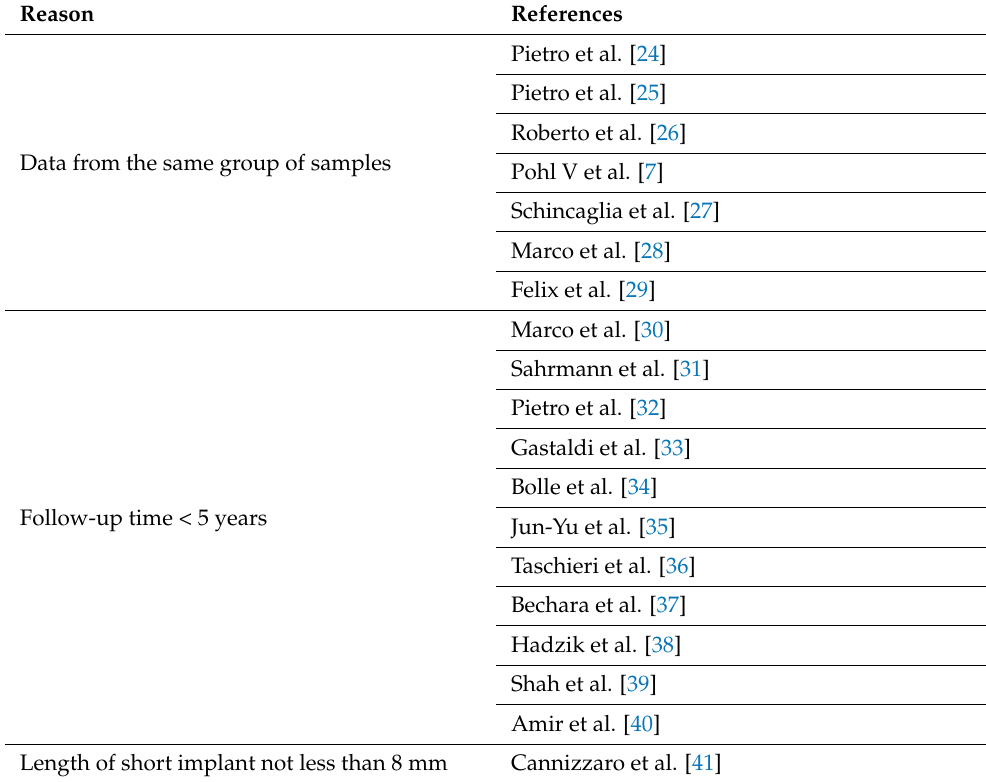
Figure 6. Comparison of marginal bone loss using short implants vs. longer implants with elevation of the sinus floor after 5 years in function via a meta-analysis. Table 1. Description of excluded studies.